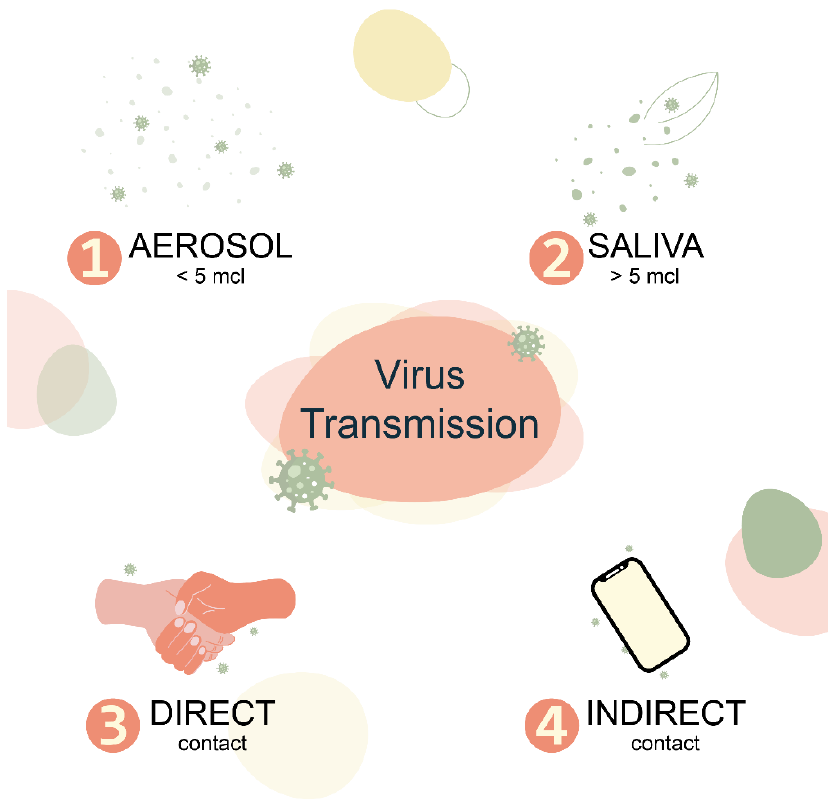
Figure 1. Most of the ways of transmission respiratory viruses.